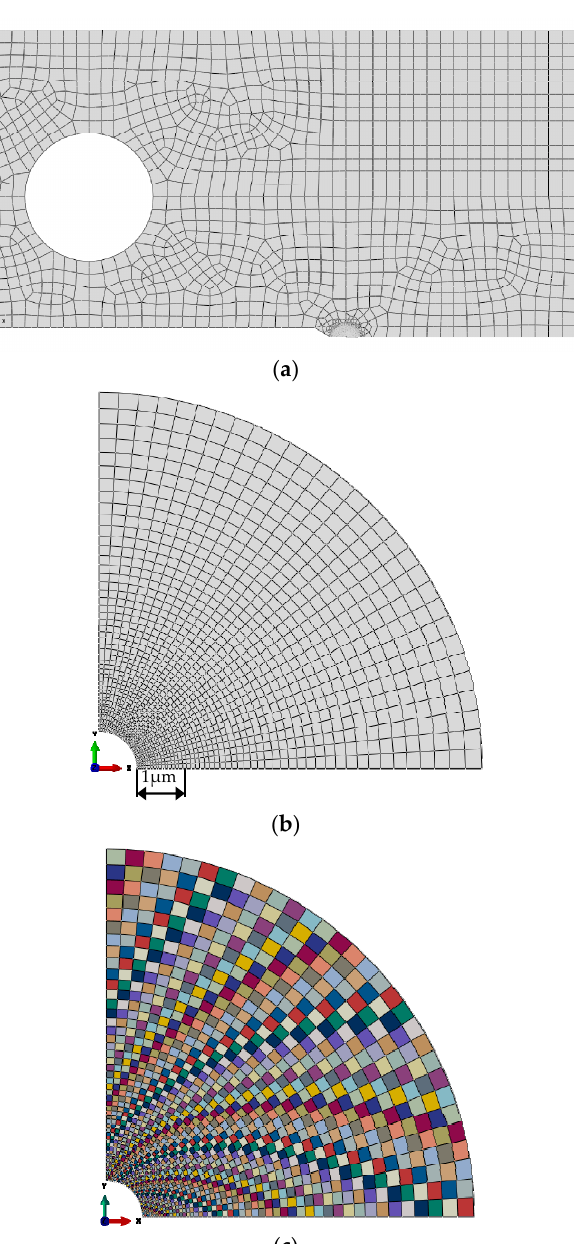
Figure 4. Finite element mesh of 1T-C.T. specimen: ( a ) mesh of half specimen, ( b ) detail around the crack tip of homogeneous material, and ( c ) detail around the crack tip of heterogeneous material.